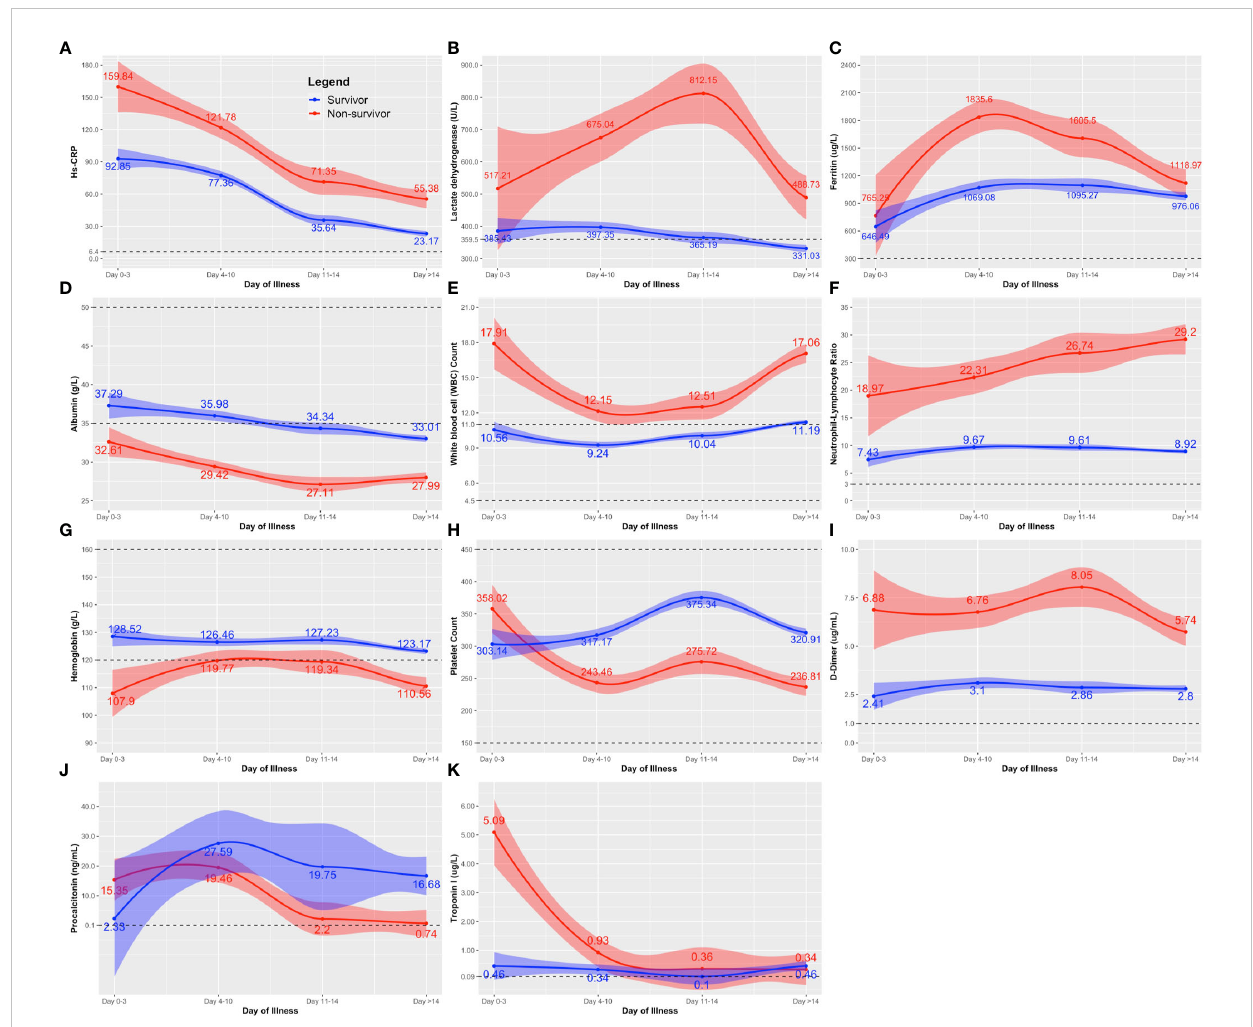
FIGURE 2 Comparison of the clinical laboratory biomarkers throughout the course of illness between COVID-19 survivors and nonsurvivors. The clinical biomarkers are: (A) hs-CRP; (B) lactose dehydrogenase (LDH); (C) Ferritin; (D) albumin; (E) white blood cell (WBC); (F) neutrophil-lymphocyte ratio; (G) hemoglobin; (H) platelet count; (I) D-dimer; (J) procalcitonin; and (K) Troponin. Line estimates were created using Locally Weighted Scatterplot Smoothing (LOWESS) showing 95% CI as shaded area around the line estimate. Points at each day interval represent mean estimate computed at that time point. Broken lines show the normal ranges of the